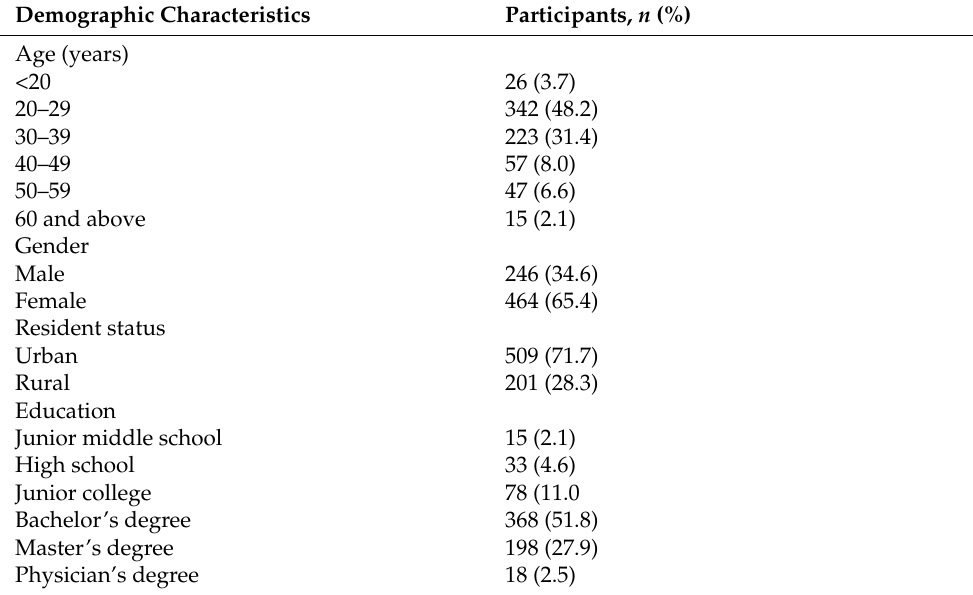
Table 1. Sample demographics ( n = 710).